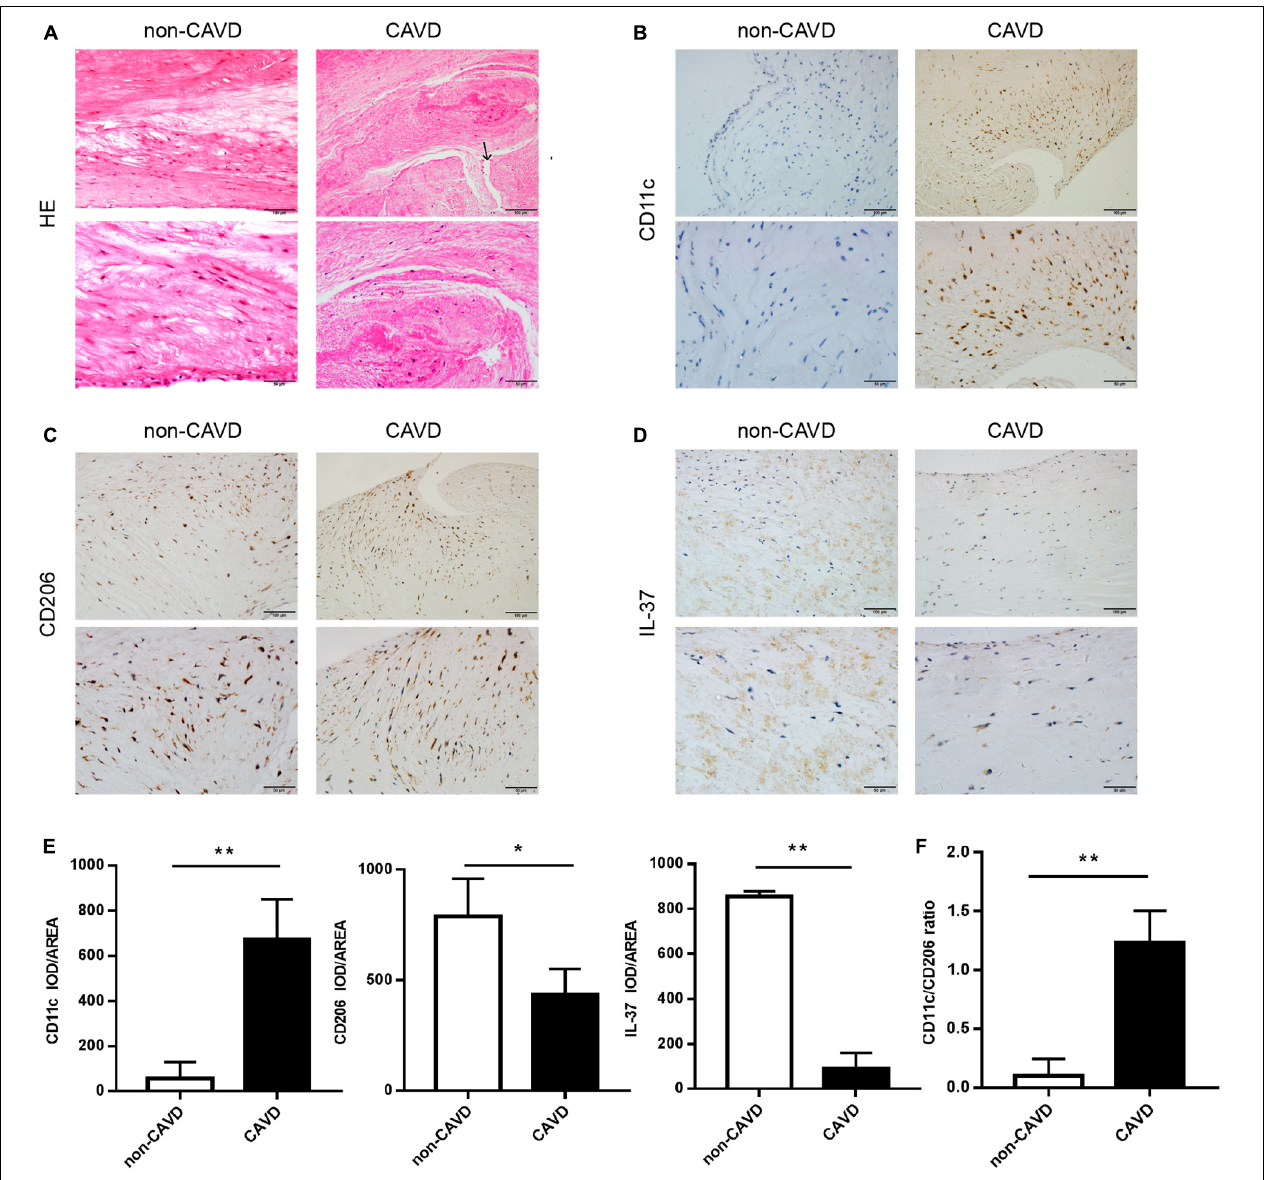
FIGURE 1 | More M1 macrophages infiltrate in calcified aortic valves, with a reduction of IL-37 expression. (A) Normal and calcified human aortic valves were stained with HE. The arrow above shows the newly blood vessels in calcified aortic valves. Magnification, 200 × and 400 × ; n = 6. (B–D) CD11c, CD206 and IL-37 expression are shown in calcified and non-calcified aortic valves. Magnification, 200 × and 400 × ; n = 6. (E) Integrated optical density (IOD)/area of CD11c, CD206 and IL-37. Magnification, 400 × , scale bar = 50 µ m. (F) CD11c + cell-to-CD206 + cell ratio in CAVD and non-CAVD. Data are presented as the mean ± SD ( n = 6); * P < 0.05, ** P < 0.01. HE, hematoxylin-eosin; CAVD, calcific aortic valve disease; non-CAVD, non-calcific aortic valve